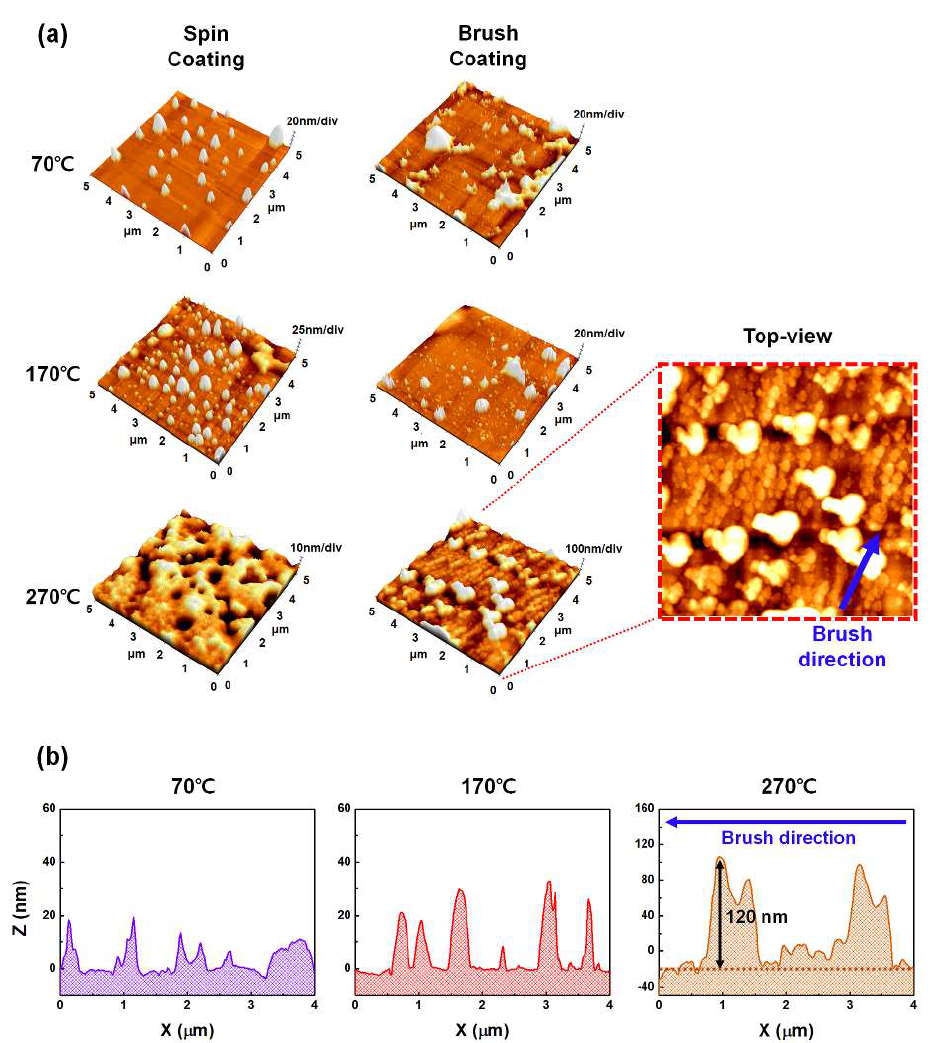
Figure 4. ( a ) Three-dimensional surface morphologies of the spin-coated and brush-coated LaYSrO films observed by AFM. The films were cured at 70, 170, and 270 °C, respectively. Particularly, the brush-coated film cured at 270 °C represents nano/micropatterns with a directionality similar to that of the brush-coating direction (blue arrow shows brush-coating direction). ( b ) Line profiles of the brush-coated LaYSrO films cured at 70, 170, and 270 °C.